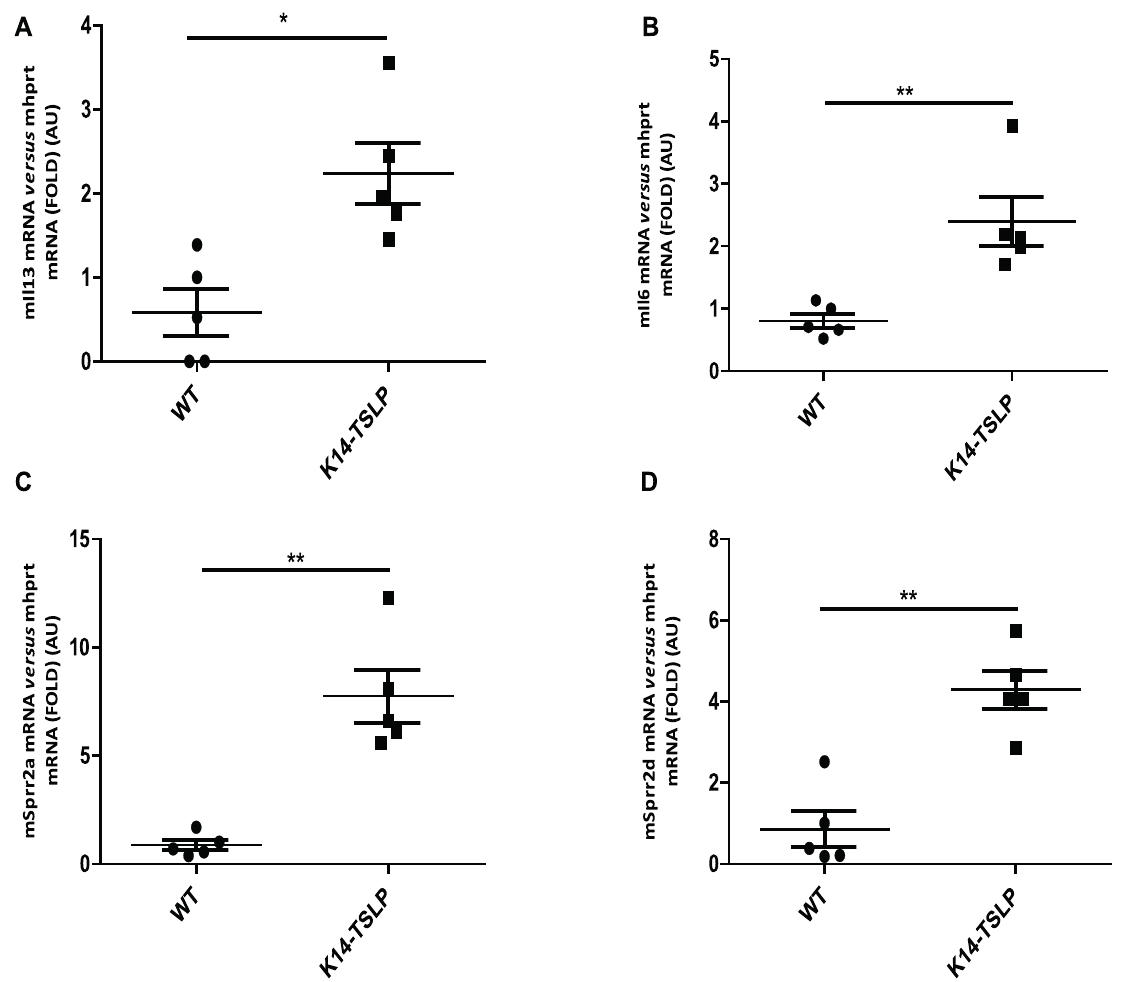
Figure 6. Real time PCR analysis of gene expression in K14-TSLP tg mouse skin. cDNA was prepared from P5 WT and K14-TSLP tg mice, and real-time PCRs were performed using primers specific for (A) Il13 , (B) Il6 , (C) Sprr2a and (D) Sprr2d . The experiment was realized in groups of 5 WT and 5 K14-TSLP P5 mice and statistically significant differences were calculated with the student T-test (*p , 0.05 and **p , 0.01).